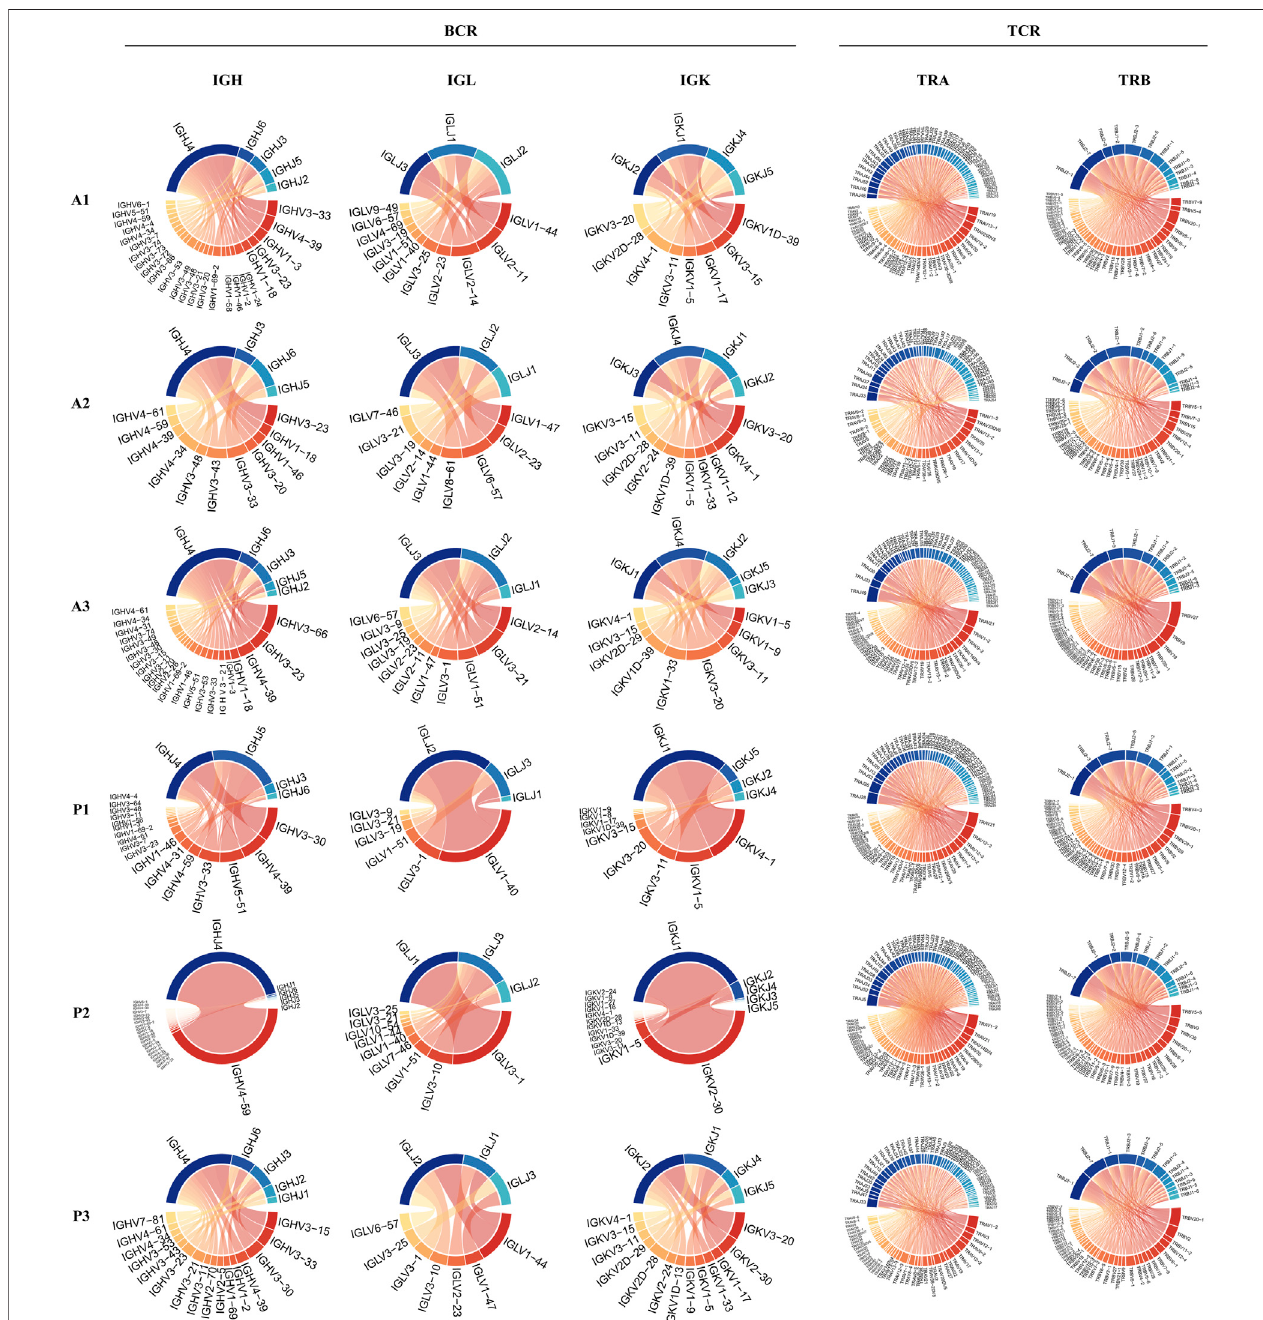
FIGURE 6 | Circos plots of IGH, IGL, and IGK recombinations of BCRs and TRA and TRB recombinations of TCRs.